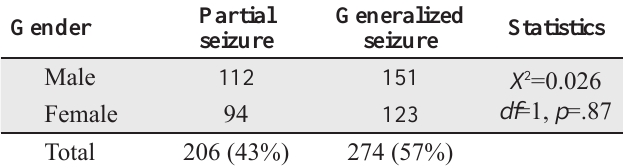
Table 1 : Relation between gender and type of seizure